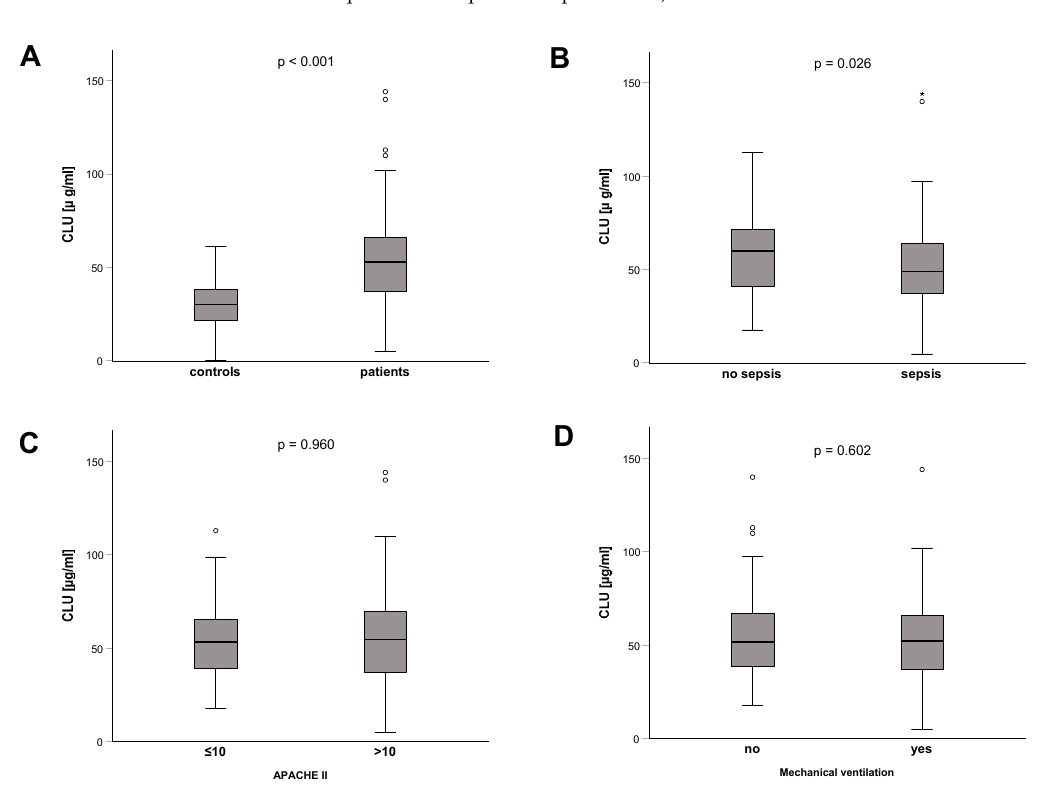
Figure 1. Clusterin levels in critically ill patients. ( A ) Clusterin plasma concentrations are significantly elevated in critically ill patients compared with healthy controls. ( B ) Clusterin levels are significantly lower in ICU patients with sepsis compared to ICU patients without sepsis. ( C ) High disease severity, as defined by an APACHE-II score above 10, is not associated with altered plasma clusterin. ( D ) The need of mechanical ventilation was not associated with clusterin levels at ICU admission. p -values (U-test) are given in the figure. Circle depicts outlier. * depicts extreme outlier.